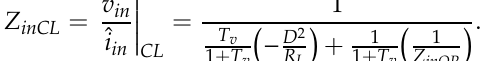
Figure 9. Schematic diagram of a typical series system.